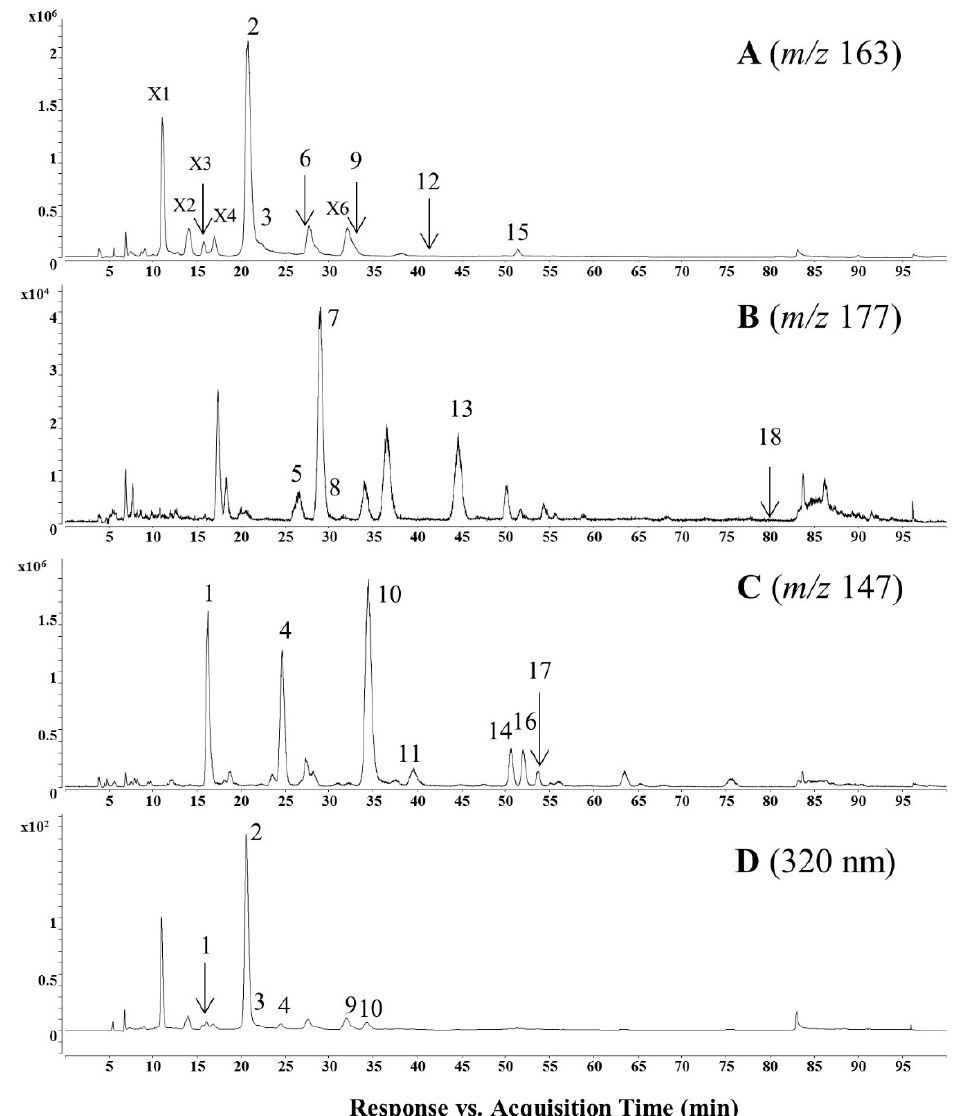
Figure 3. Base peak chromatogram and extracted ion chromatograms of EtOAc fraction of C. salsa analyzed by HPLC-ESI-QTOF-MS in positive mode: ( A ) Caf at m/z 163; ( B ) Fer at m/z 177; ( C ) Cou at m/z 147; ( D ) base peak chromatogram at 320 nm.